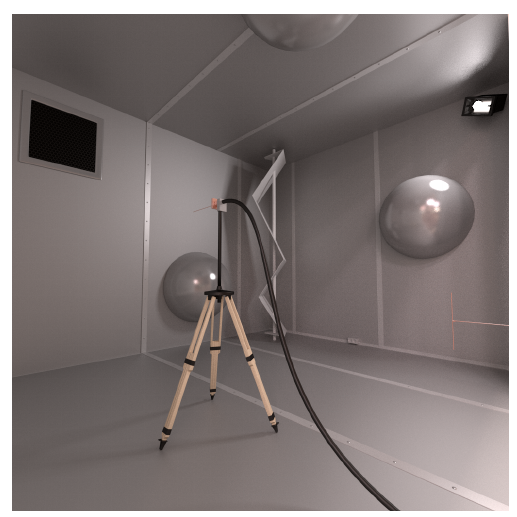
Figure 7: Artist 3D-view of the reverberation chamber made chaotic through the addition of 3 half-spheres. The volume of the RC is 19.1 m 3 without the half-spheres, each having a radius of 40